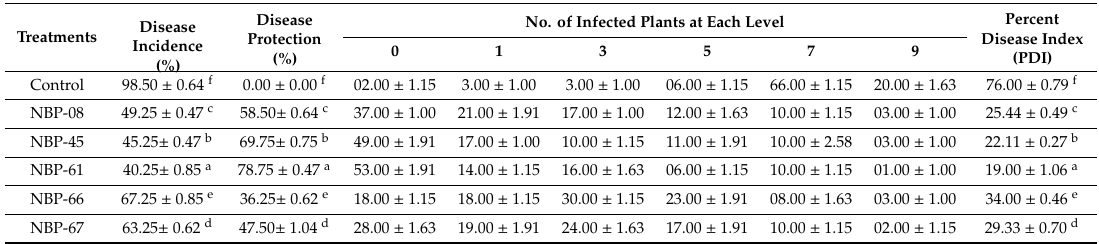
Table 5. E ff ect of PGPF seed treatment on the induction of disease resistance in chilli against anthracnose